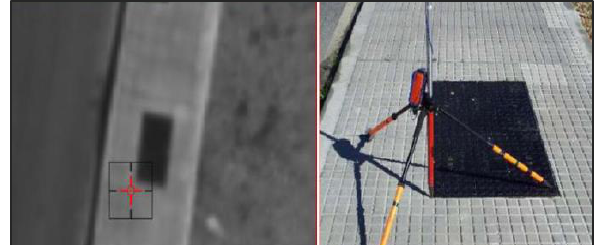
Figure 5. This black vault is visible on high resolution imagery, but will blend in with lower resolution imagery by